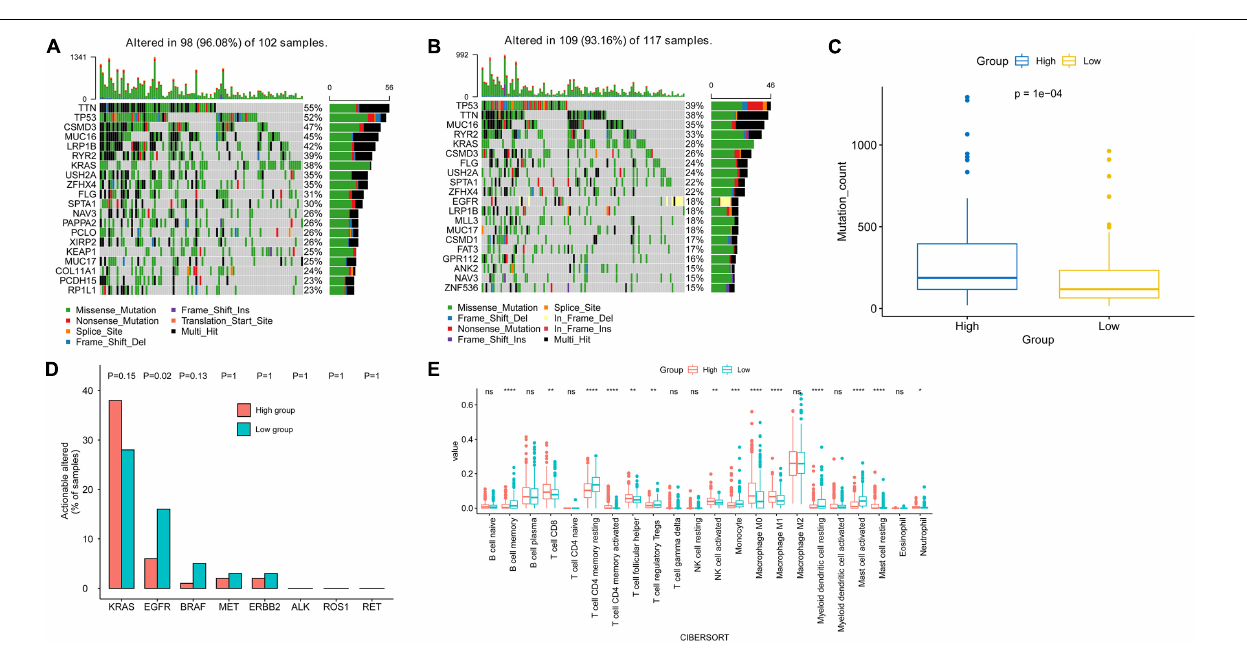
FIGURE 5 | HALLMARK (A) and Kyoto Encyclopedia of Genes and Genomes (KEGG) (B) enrichment analysis in the high-risk and low-risk subgroups. The enriched items were selected with a corrected q-value 0.01; the length and color of the bar represent the absolute value of NES and the q-values, respectively. NES: normalized enrichment score.